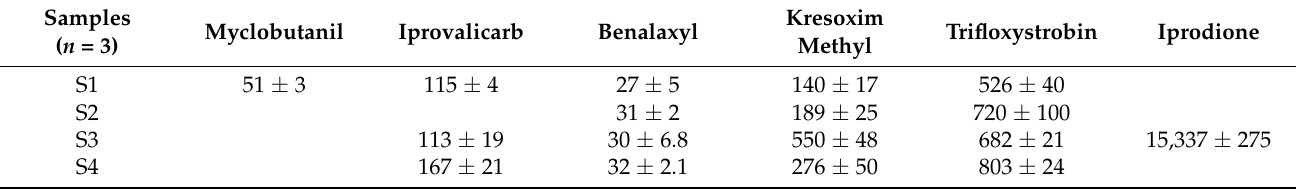
Table 5. Concentration ± SD (ng g − 1 ) of fungicides in soil samples by UAE-GC-MS/MS.